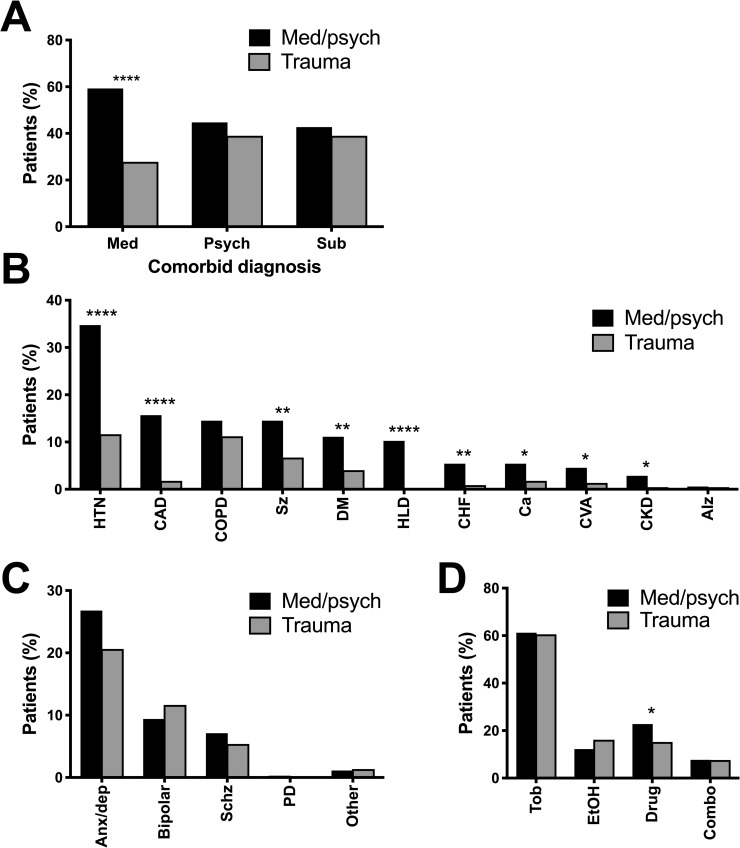
Patients with medical or psychiatric chief complaints had more medical comorbidities than patients with trauma-related complaints.For incarcerated patients presenting to a tertiary care, academic emergency department between January 2012 and December 2014 with medical or psychiatric and trauma-related complaints, the percent of medical, psychiatric, or substance abuse disorder (A) comorbidities was calculated. The percent of individuals with specific medical (B), psychiatric (C), and substance use disorder (D) comorbidities was quantified. Shown in percent (%) of patients. Alz, Alzheimer’s disease or dementia; anx/dep, anxiety and/or depression; Ca, cancer; CAD, coronary artery disease or history of a myocardial infarction; CHF, chronic heart failure; CKD, chronic kidney disease; Combo, combined drugs and alcohol; COPD, chronic obstructive pulmonary disease or asthma; CVA, cerebral vascular accident or history of a transient ischemic attack; DM, diabetes mellitus; EtOH, alcohol; HLD, hyperlipidemia; HTN, hypertension; PD, personality disorder; Psych, psychiatric; Schz, schizophrenia or psychotic disorder; Sub, substance abuse; Sz, seizures; Tob, tobacco. * p < 0.05, ** p ≤ 0.005, **** p < 0.0001.